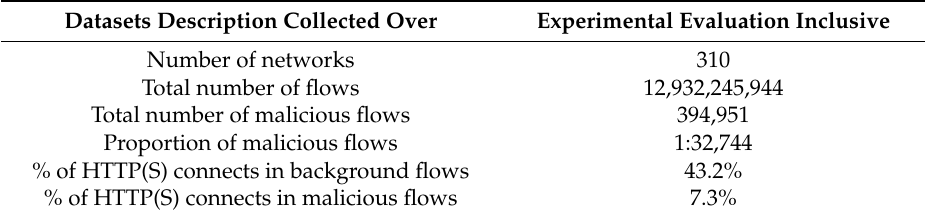
Figure 5. Number of flows counts per network according to the number of company’s identification ID. Table 2. Characteristics of the datasets used for experimental